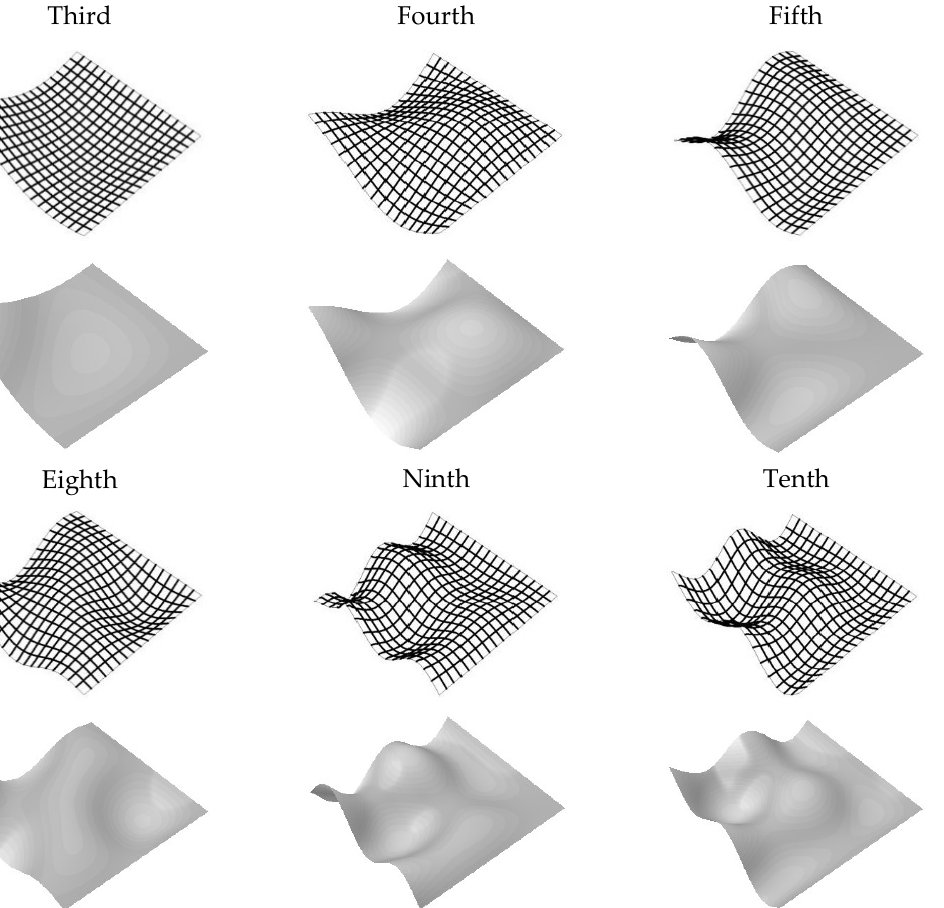
Figure 4. First ten mode shapes of the square SSFF plates with µ = 0.3 , r x 0 = 0.000001 and r y 0 = 0.000001 .